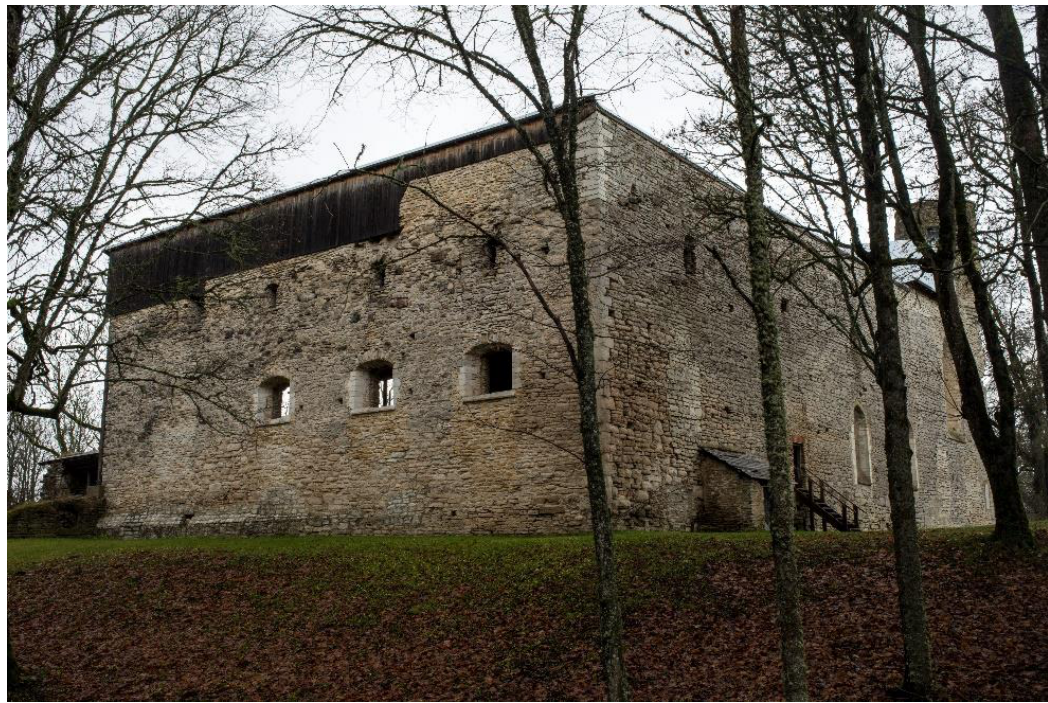
Figure 1. Padise Abbey in 2017.